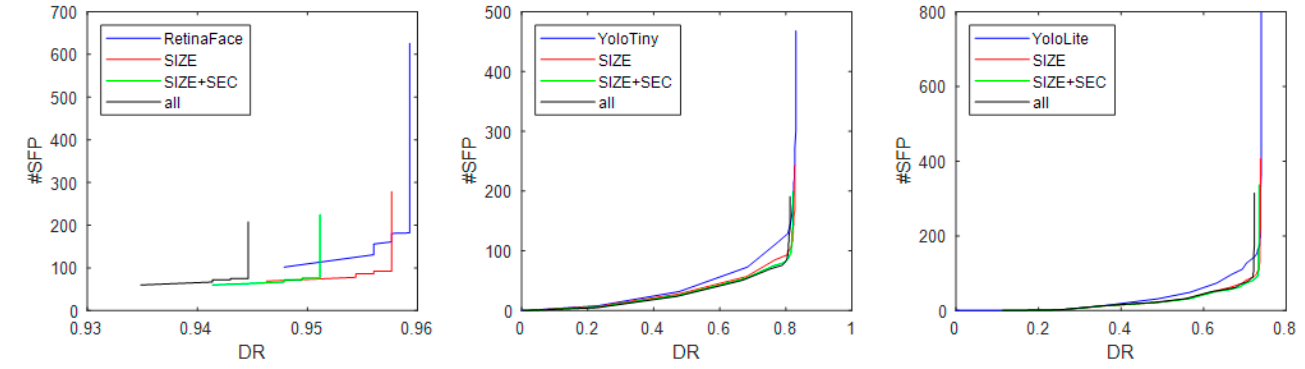
Figure 8. Plot of the detection rate vs. number of string false positives for the 3 face detectors (RetinaFace, YOLOv7Tiny, YOLOv7Lite) on the original dataset.